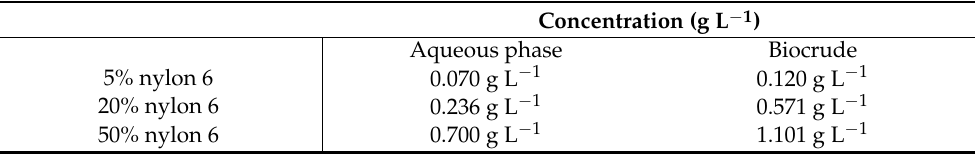
Table 1. Quantitative analysis obtained for the selected nylon breakdown products in both the aqueous phase and oil phase for coliquefaction of nylon with